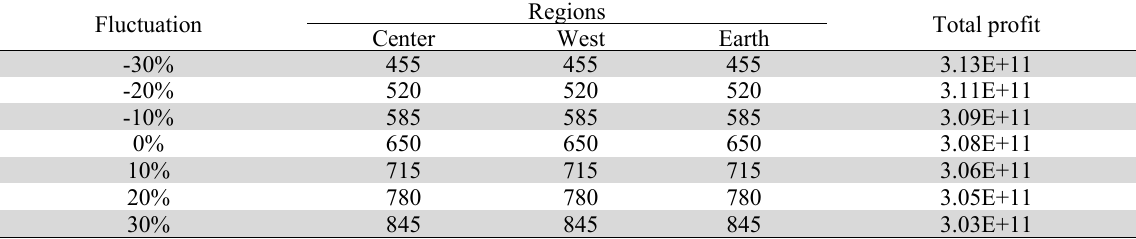
Total profit vs. fluctuations in the cost of groundwater Fluctuation